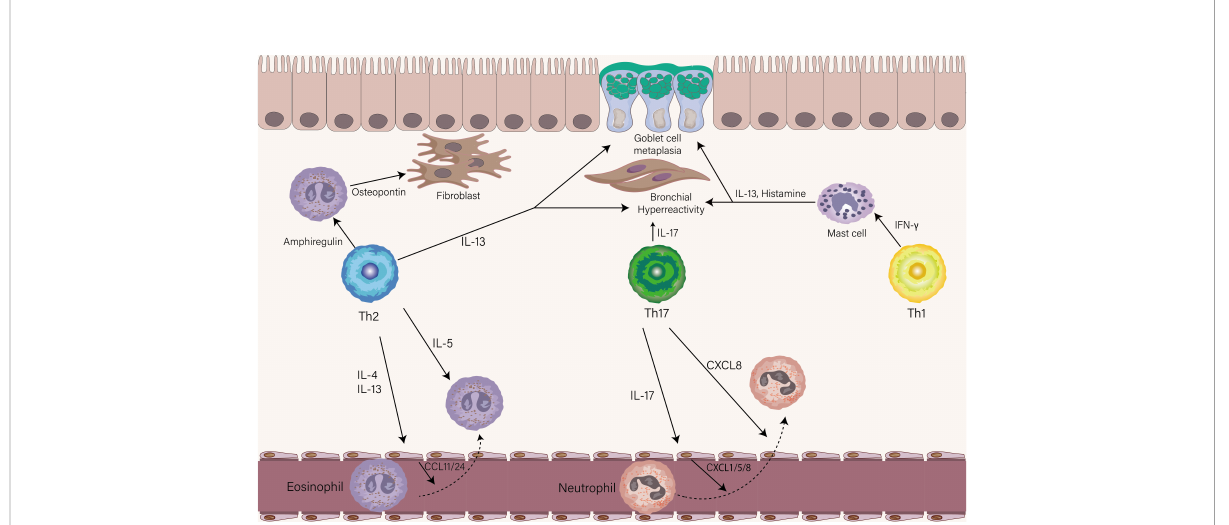
FIGURE 3 The role of Th1, Th2, and Th17 cells in stable asthma. The eosinophils-recruiting chemokines CCL11 and CCL24 from the endothelial cell are induced by IL-4 and IL-13 from Th2 cells. IL-5 produced by Th2 cells then leads to the activation of eosinophils. Similarly, the neutrophil- attracting chemokines CXCL1, CXCL5, and CXCL8 by endothelial are induced by IL-17 from Th17 cells. Th17 cells could also directly chemoattract neutrophils via the release of CXCL8. The production of Amphiregulin and IL-13 is from Th2 cells. Amphiregulin acts on eosinophils to produce osteopontin which triggers airway fi brosis. IL-13 mainly drives goblet cell metaplasia and AHR. IL-17 produced by Th17 cells contributes to the AHR. IFN- g effects on mast cells increase their ability to release histamine and IL-13, leading to AHR and goblet cell